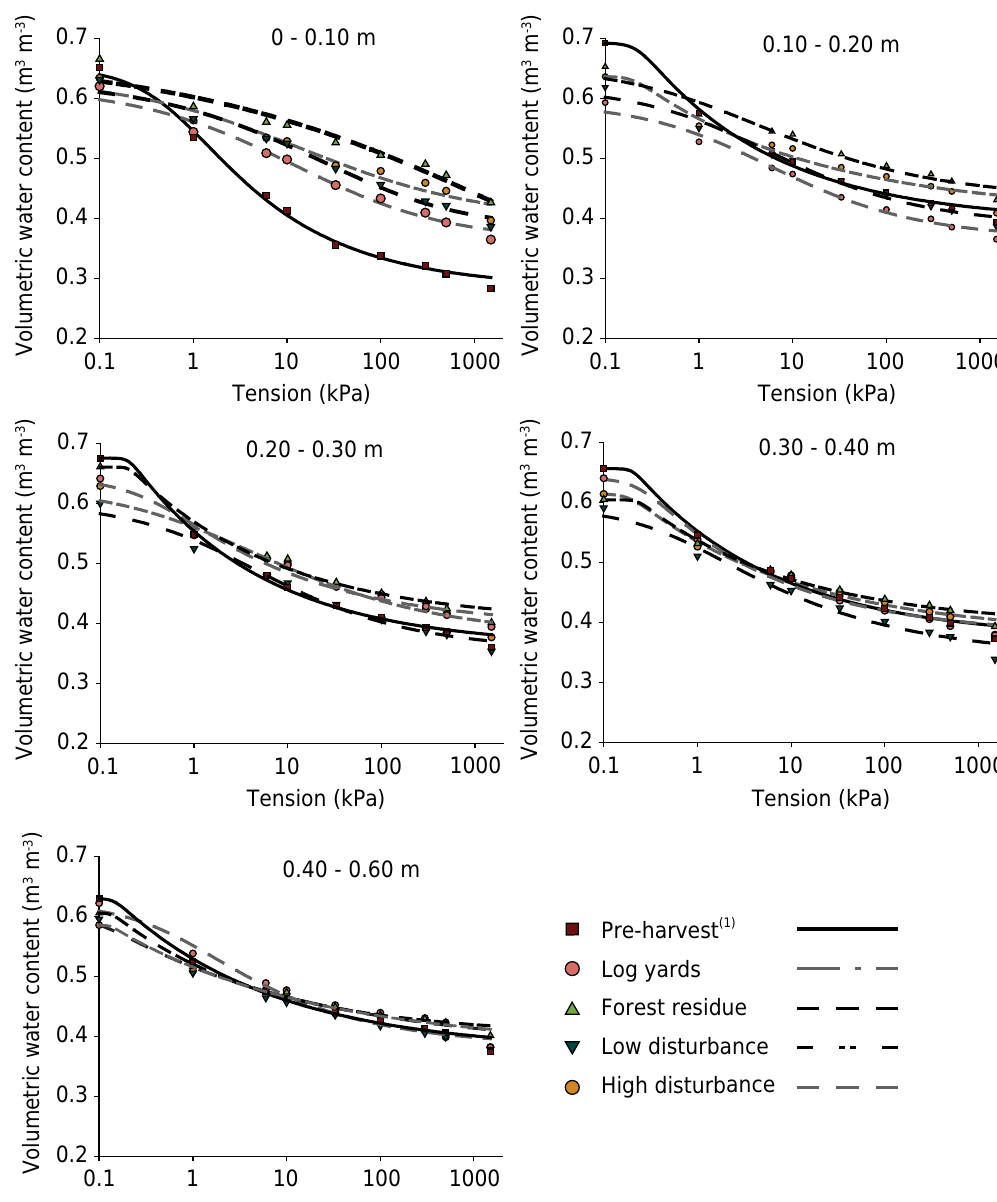
Figure 4. Water retention curves of a Dystric Cambisol (Humic) at pre-harvest (control) and post-harvest, in the areas of log yard, forest residues, low disturbance and high disturbance, in five layers of the soil in a Pinus taeda reforestation. (1) The symbols represent the moisture measured for each tension and the lines represent the van Genuchten equation adjustment in the different areas and layers